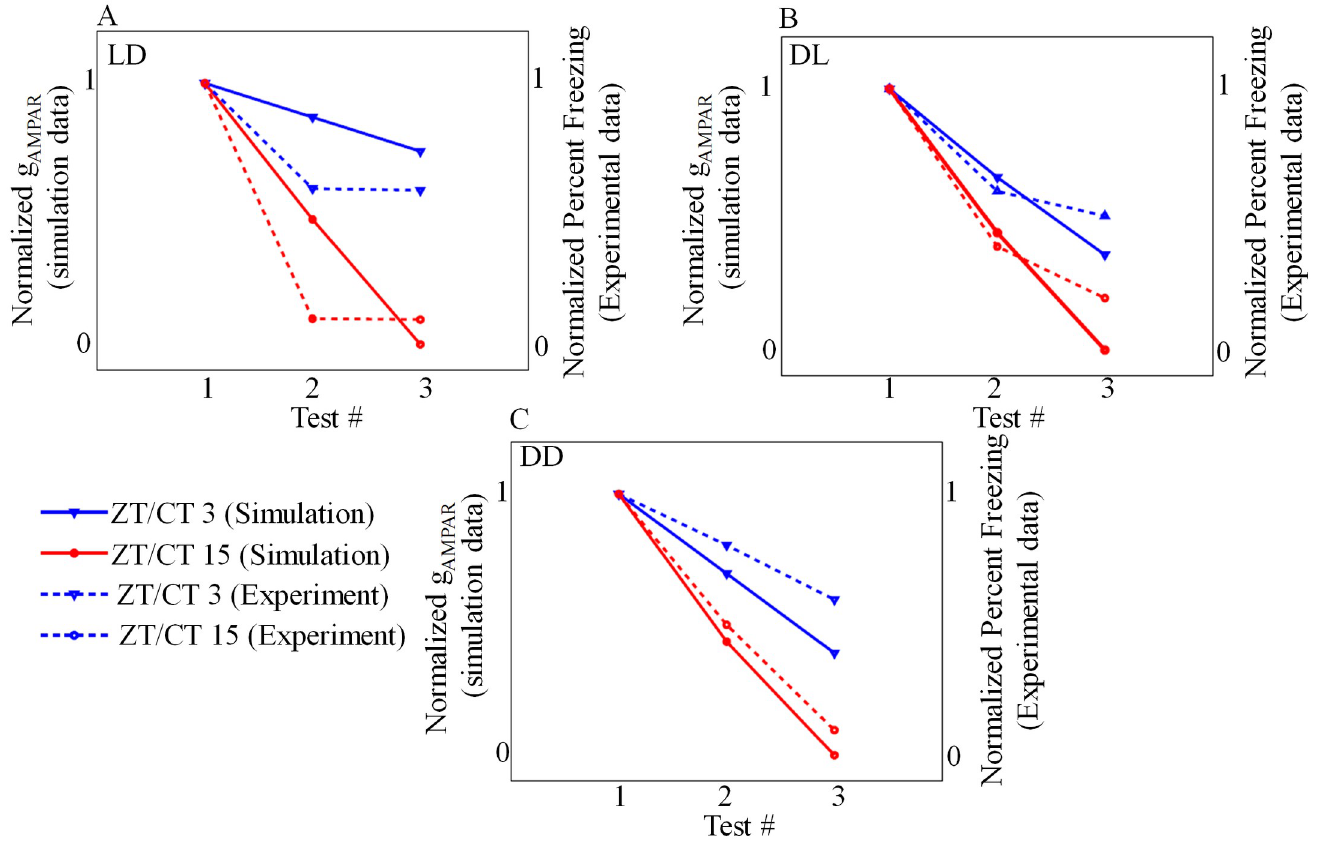
Fig 12. Extinction. Model is trained and tested for extinction either in day or night. Degree of extinction is higher in model trained and tested at night (A-C, red triangle). (A) Model forced by 12:12 LD cycle (B) model forced by 12:12 DL cycle (C) model is under DD condition. For comparison, g the first extinction test at day and night are normalized to 1 and minimum value is normalized to 0. it is clear that degree of extinction is more during night. Experimental data points are extracted from [14].